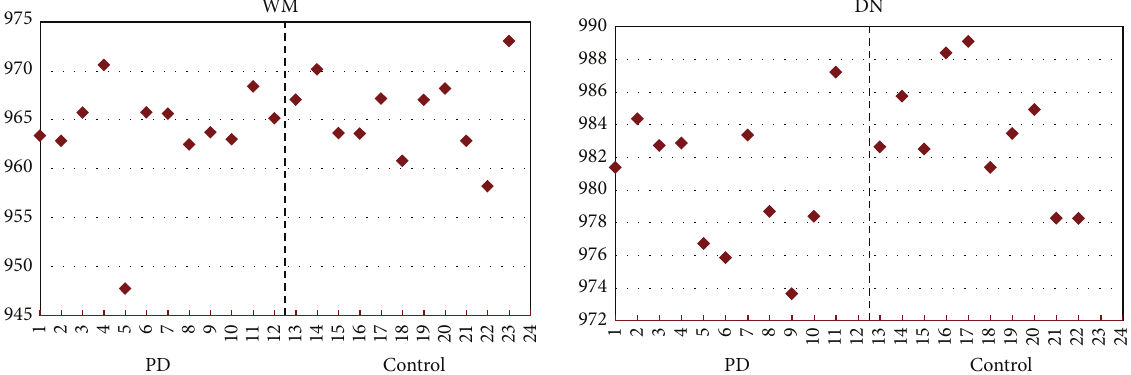
Figure 3: Heterogeneity of phase values in various brain regions among study subjects. CN: caudate nucleus, PUT: putamen, GP: globus pallidus, RN: red nucleus, SN: substantia nigra, THA: thalamus, GM: gray matter, DN: dentate nucleus, and WM: white